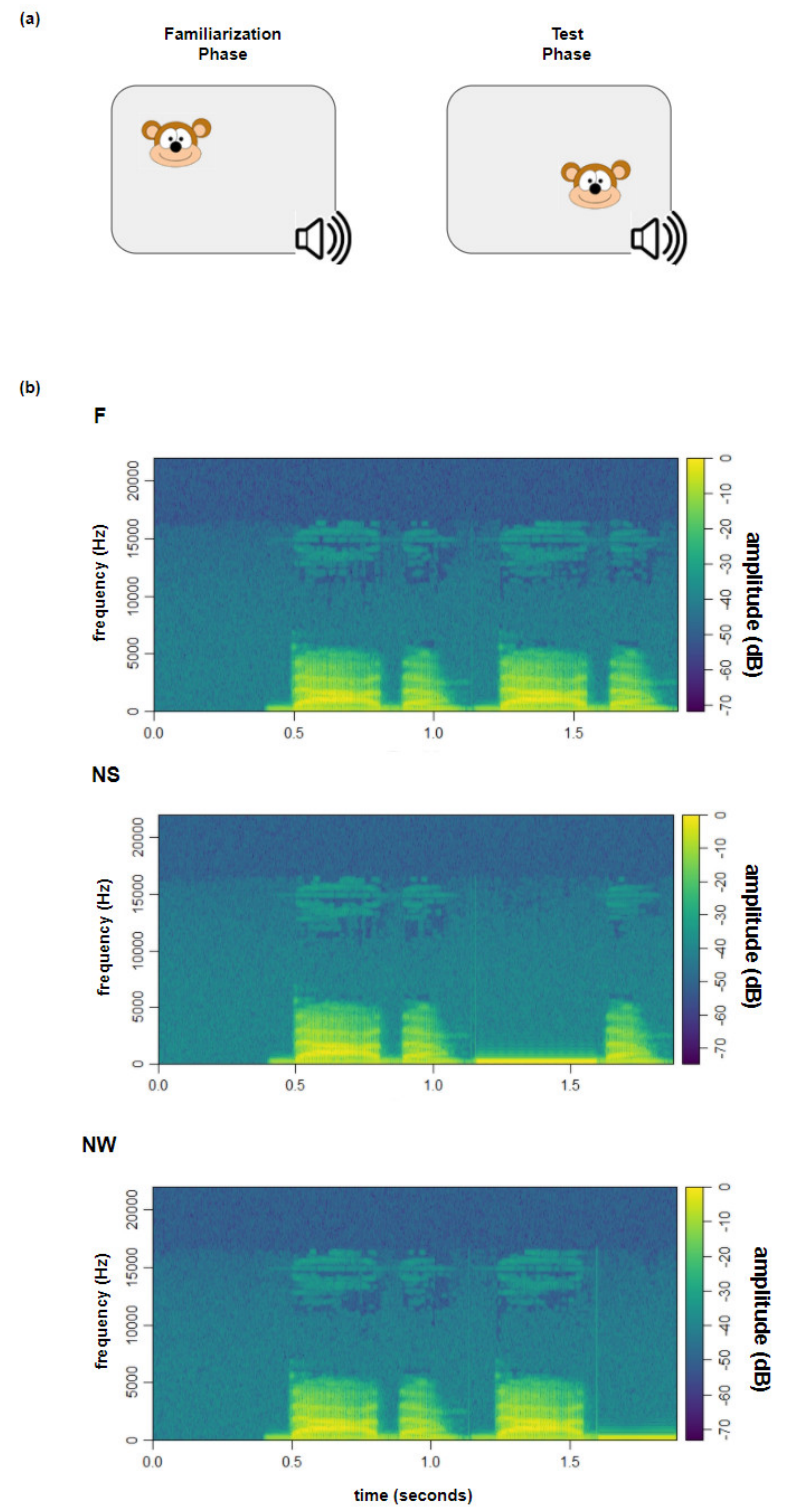
Figure 3. ( a ) Familiarization task, consisting of the familiarization (FP) and the test (TP) phase; and ( b ) spectrogram of frequencies (left vertical axis) and an amplitude spectrum (right vertical axis) of the auditory sequence during the familiar phase, e.g., /Dada/ /Dada/ of audio stimuli across conditions for the test phase (i.e., F, NS, NW). Note that the stimuli of the familiarization phase are the same as those presented during the familiar (F) condition in the test